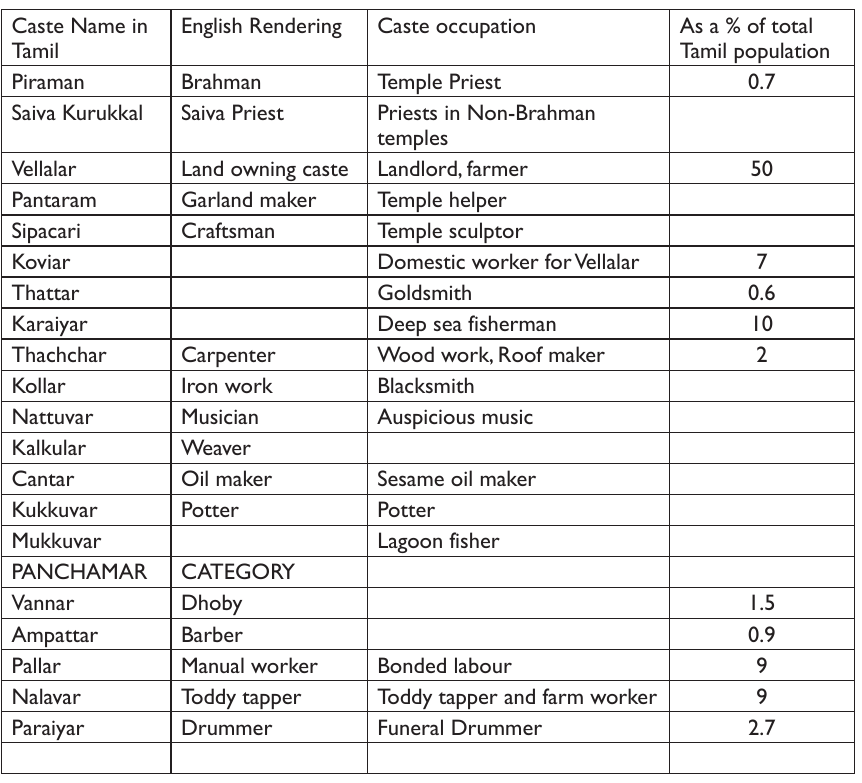
Table 1. Castes in Jaffna Peninsula,